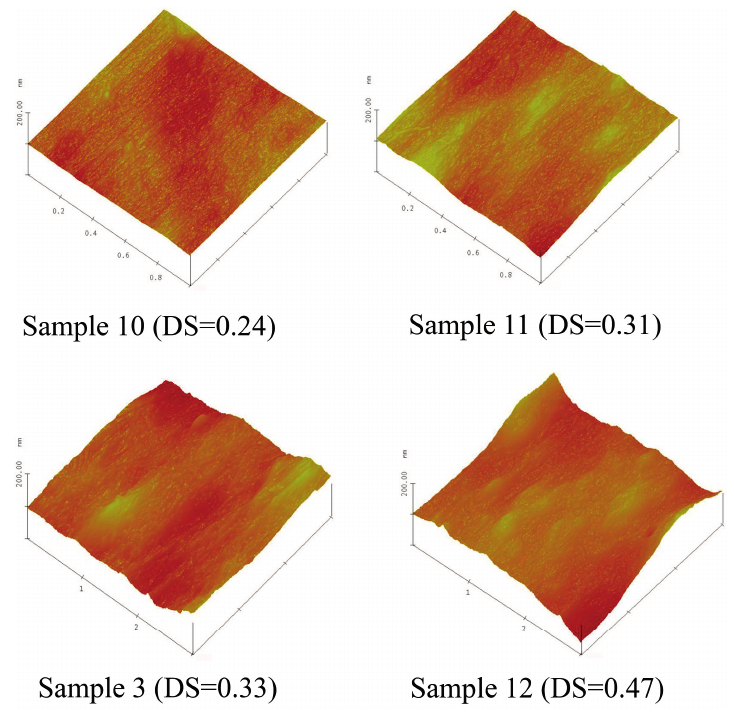
Figure 7. AFM images of xylan- g -PPC